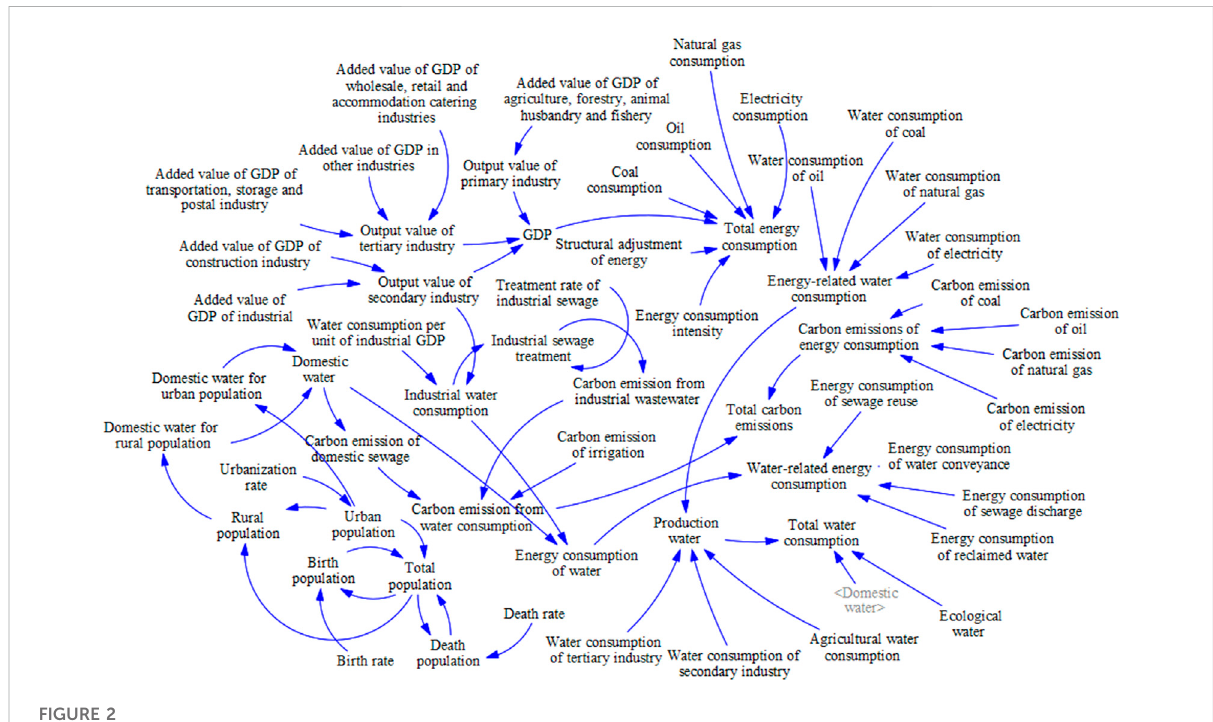
FIGURE 2 Causal loop diagram of the carbon emissions in